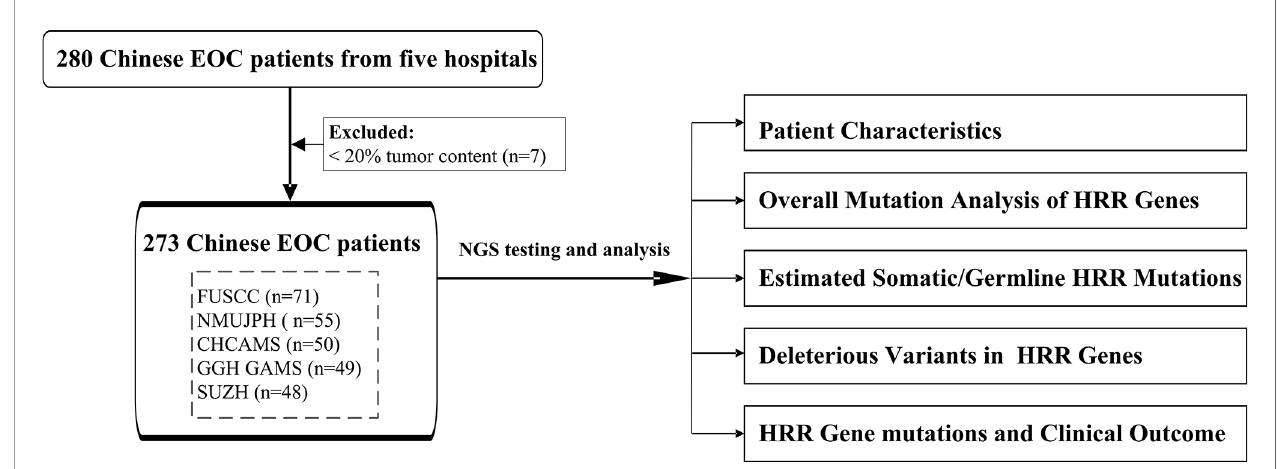
FIGURE 1 | The work fl ow diagram of this study. FUSCC, Fudan University Shanghai Cancer Center; NMUJPH, The First Af fi liated Hospital of Nanjing Medical University; CHCAMS, National Cancer Center/National Clinical Research Center for Cancer/Cancer Hospital, Chinese Academy of Medical Sciences and Peking Union